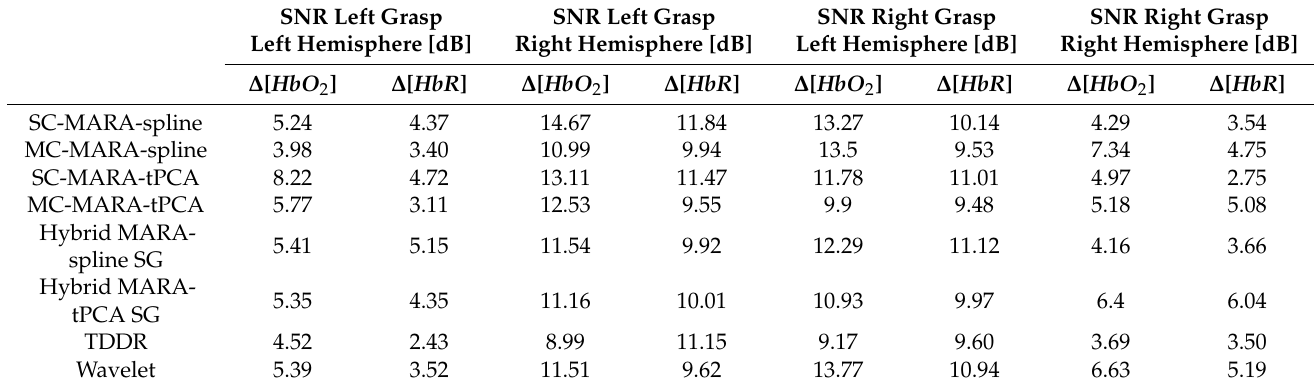
Table 3. Median value of block-averaged responses of SNR [dB] across all subjects, motor task conditions, and hemispheres. SNR was computed over motor channels displayed in Figures 7 and